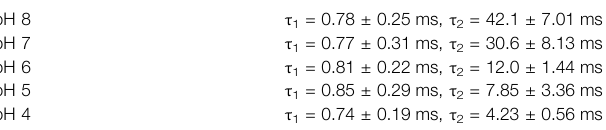
TABLE 1 | pH dependence of the decay of the photocurrents of Um Rh1. Fitting the decays with the sum of two exponentials (see Figure 5B for a set of representative traces) resulted in the time constants τ 1 and τ 2 with the relative deviation derived from fi ve independent experiments recorded under the same